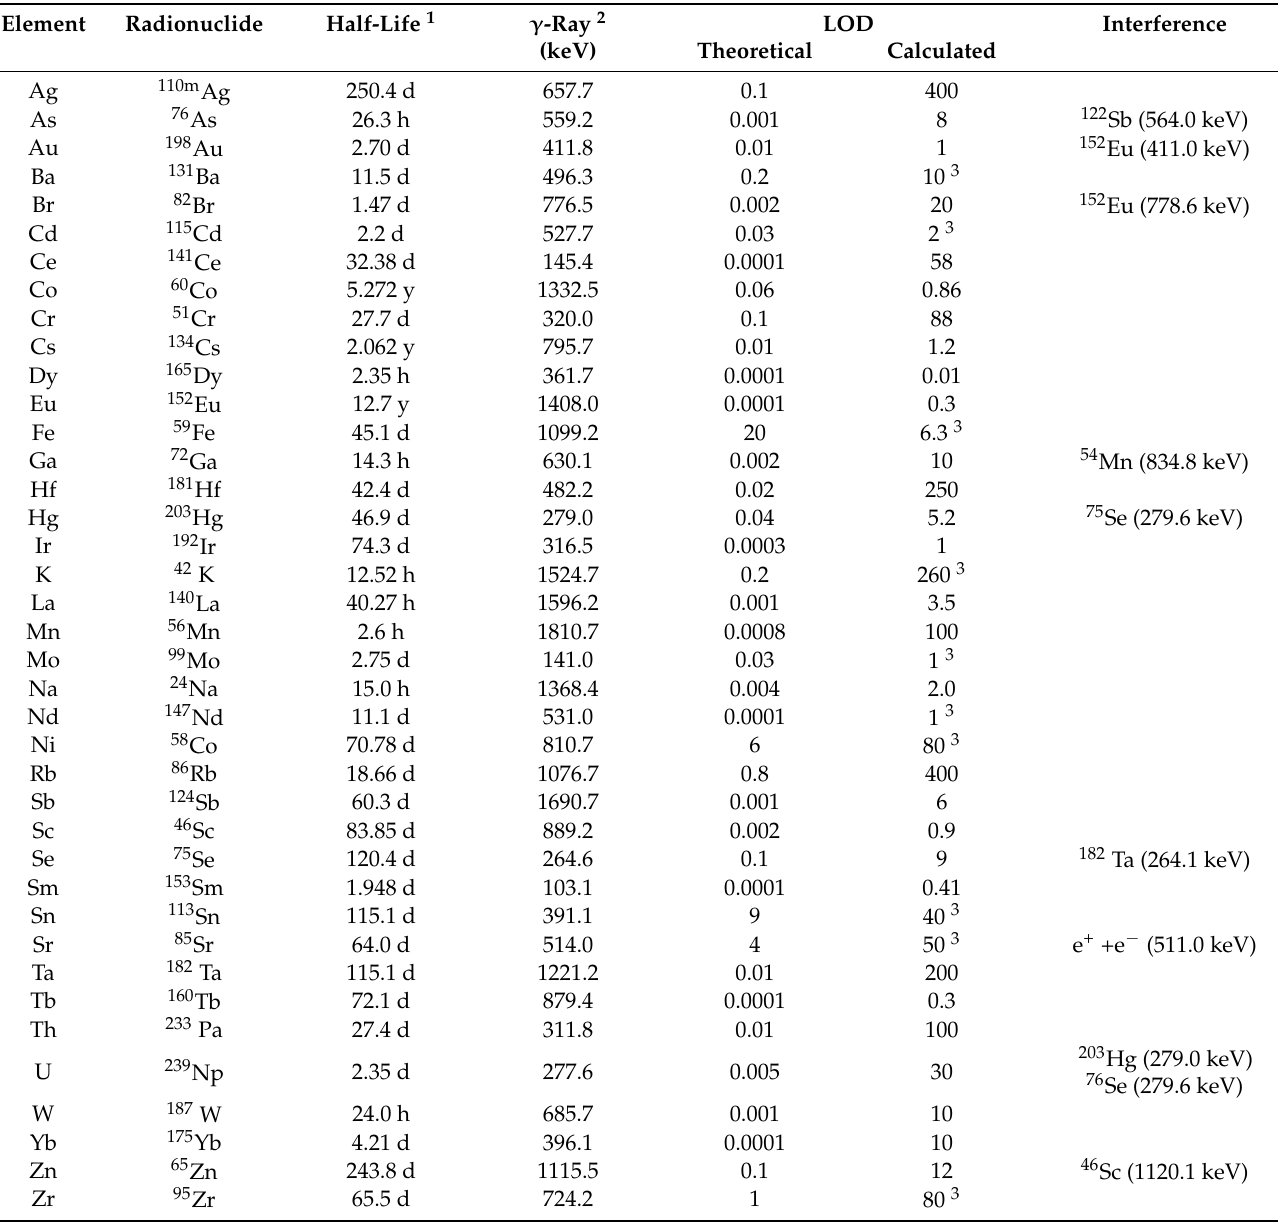
Table 2. Nuclear data and limit of detection (LOD; theoretical in ng, calculated according to ref. [38] in ng g − 1 ) of each element determined by nuclear analytical technique